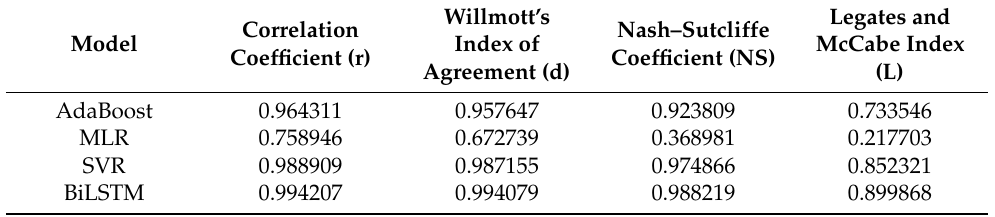
Table 5. Model performance metrics for Kiribati.